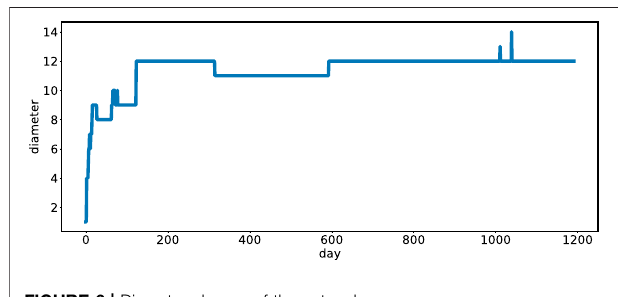
FIGURE 6 | Diameter change of the network.